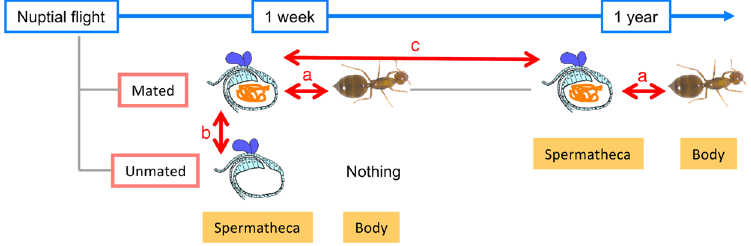
Figure 1. Sample preparation schematic: Differential gene expressions patterns were compared between ( a ) the spermatheca and the body, ( b ) the spermatheca from virgin and inseminated queens, and ( c ) the spermatheca at 1 week and 1 year after